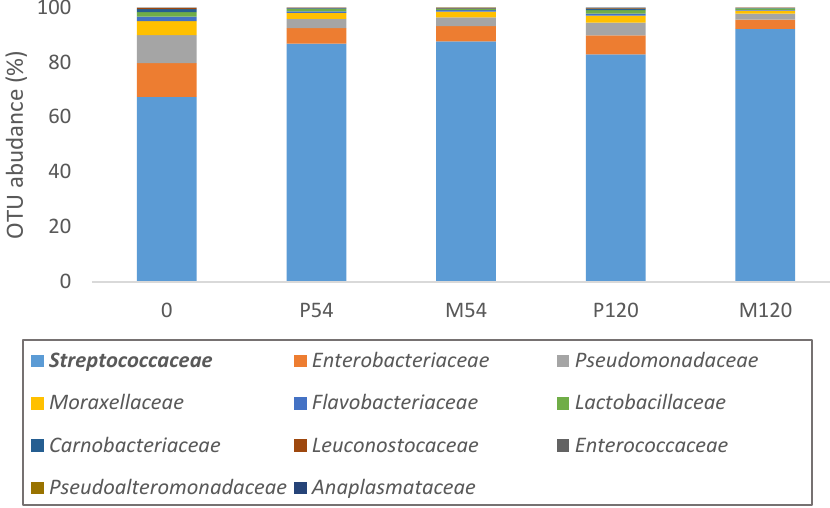
Figure 1. Abundance of the main families found in the feta cheese PDO samples during ripening (0,54, 120 days) in plastic (P) and stainless steel (M) container .